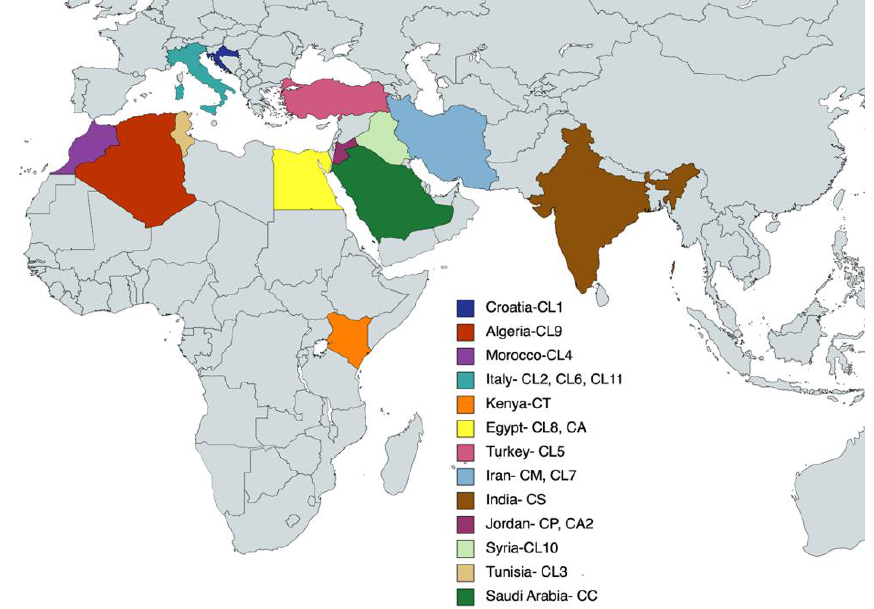
Figure 2. EMEA map showing essential oil samples considered in this study. The resultant essential oil analysis of Capparis species regardless of plant part or geo- graphical location were considered in this statistical analysis with the only exclusion criteria being complete absence of similarity to CC (present study). Evidently, excluded samples shared no chemical constituents at a quantity of 1% or over with the oil analysed in the present study. Due consideration of the impact of environmental factors and plant organ specification is factored into the interpretation of the MVA results presented in Figures 3 and 4.